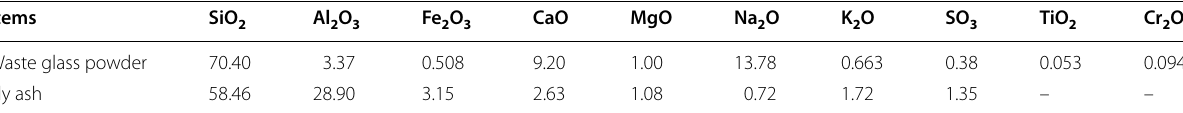
Table 3 Chemical composition of waste glass powder and fly ash (% by